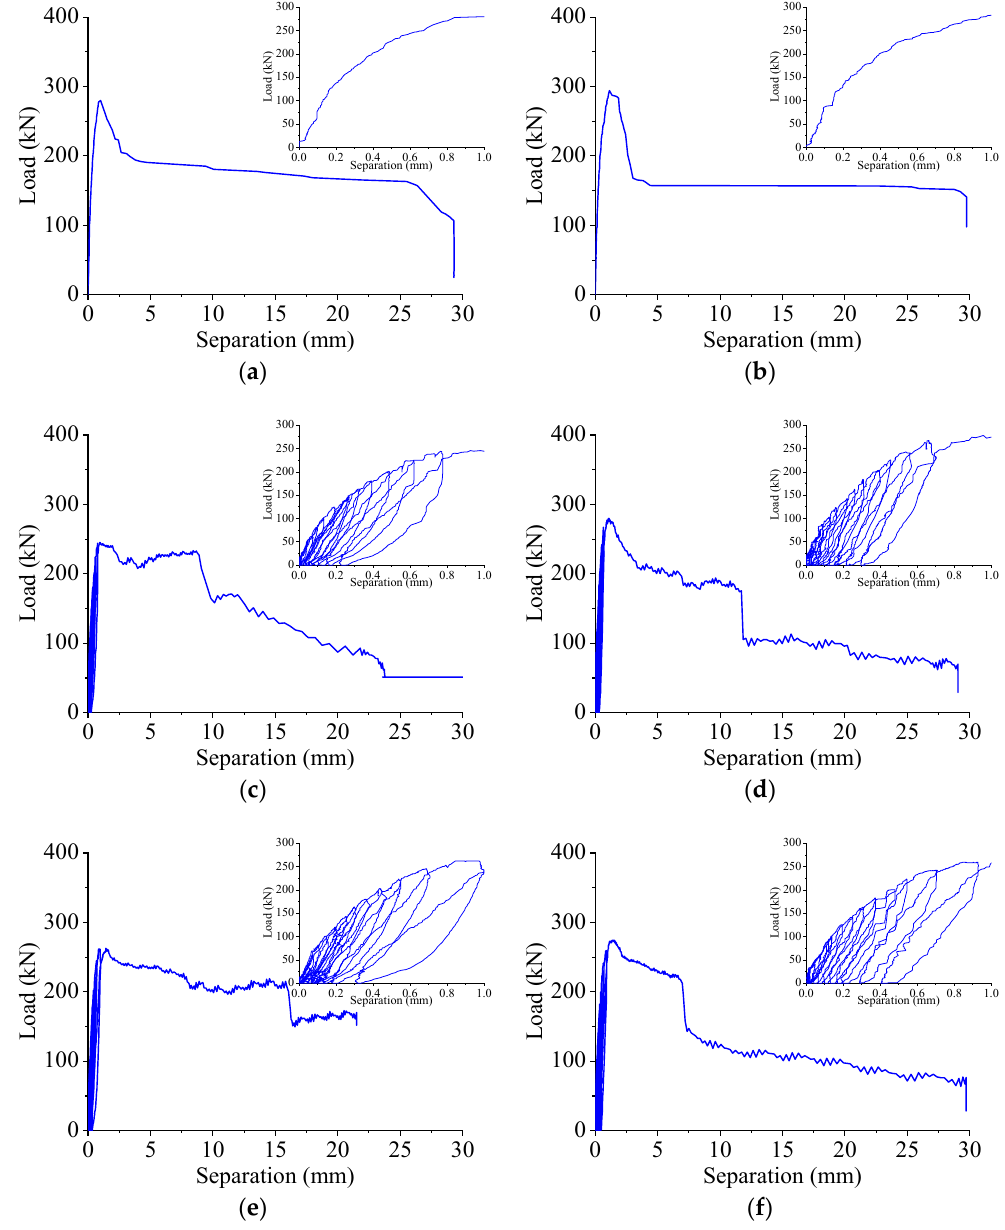
Figure 5. Load–separation curves. ( a ) CPT–1; ( b ) NPT–1; ( c ) CPT–2; ( d ) NPT–2; ( e ) CPT–3; ( f ) NPT–3.